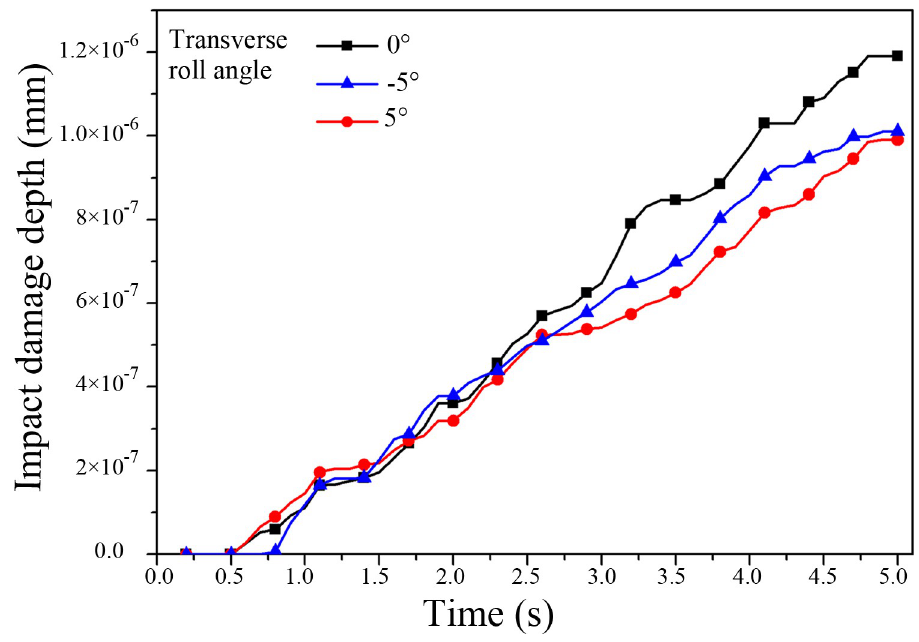
Fig 6. Impact damage depth curve of the middle trough under the different transverse roll angles.